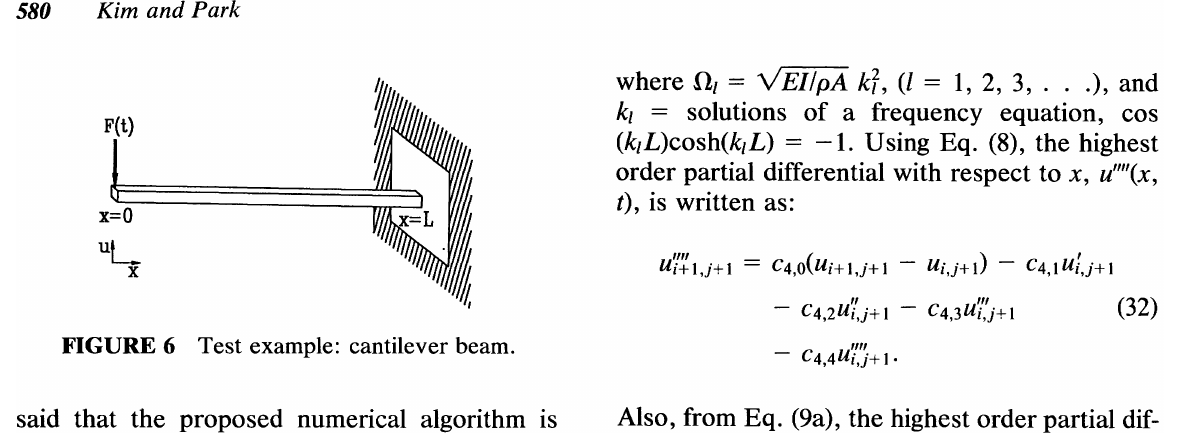
FIGURE 6 Test example: cantilever